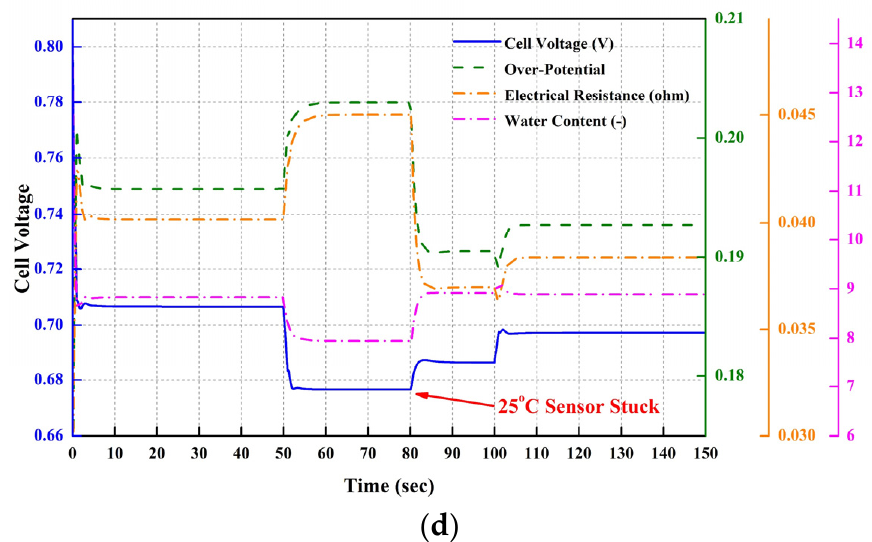
Figure 4. Transient sensor fault behavior in PEM fuel cell under sudden stack sensor stuck (( a ) Temperature of stack and coolant inlet, ( b ) cooling components, ( c ) heat rejection in stack, ( d ) voltage